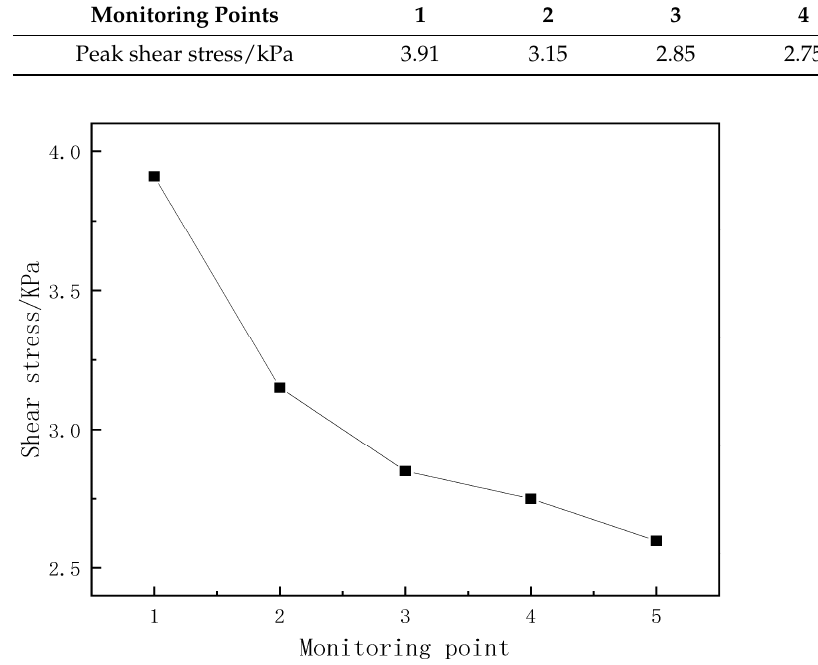
Table 12. The peak horizontal radial shear stress at an elevation of 20 m.